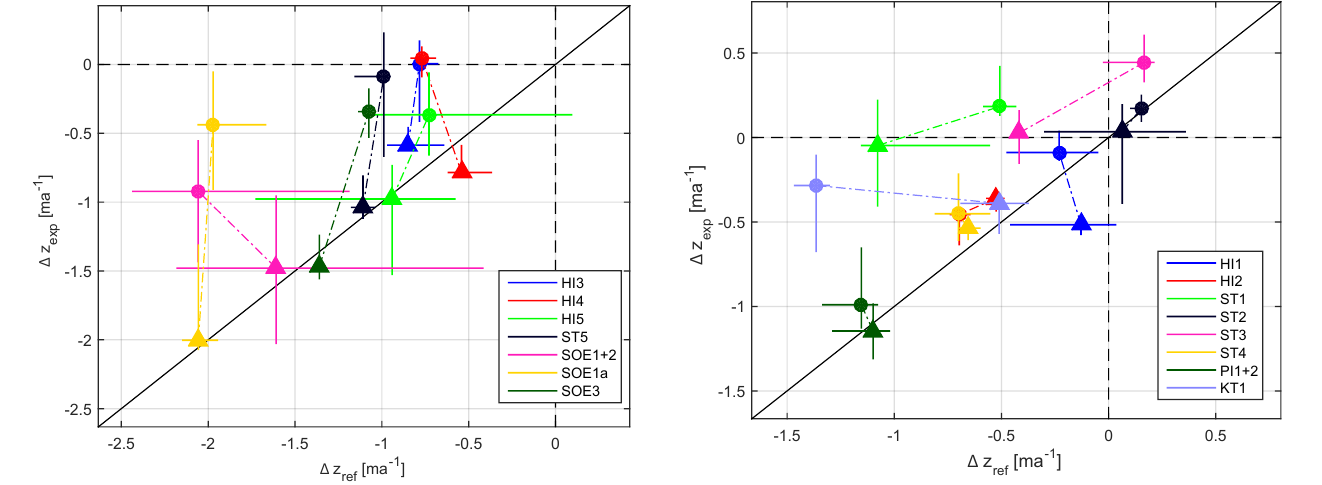
Figure 5. Median of the annual surface elevation changes in refer- ence areas ( (cid:49)z ref ) compared to the median of the annual surface el- evation changes in experimental areas ( (cid:49)z exp ) for the periods with- out (triangles) and with (circles) mass balance management. Peri- ods are given in Table 2. Solid lines show the interquartile range between the 25th and the 75th percentile. Dashed lines connect the corresponding values of one profile.